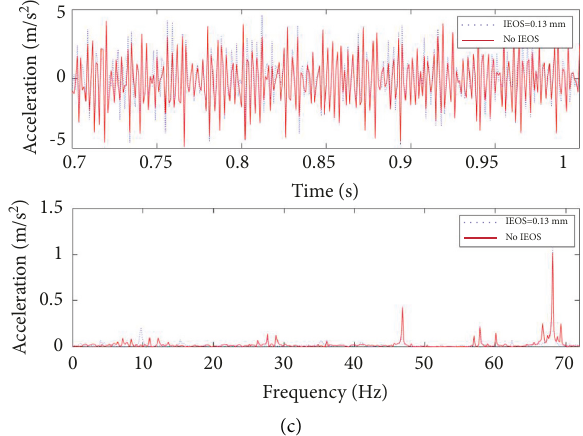
Figure 6: Vibration acceleration responses ring gear under the IEOS of the 1st planet gear. (a) Horizontal direction. (b) Vertical direction. (c) Axial